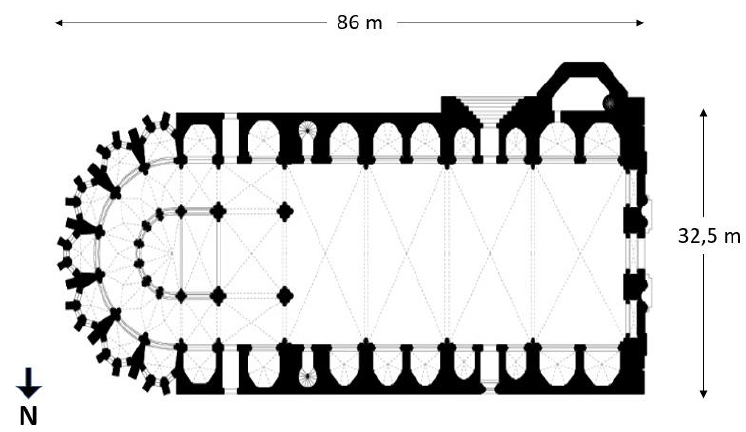
Figure 2. Plan of the Girona Cathedral. Source: Girona Cathedral Archive.